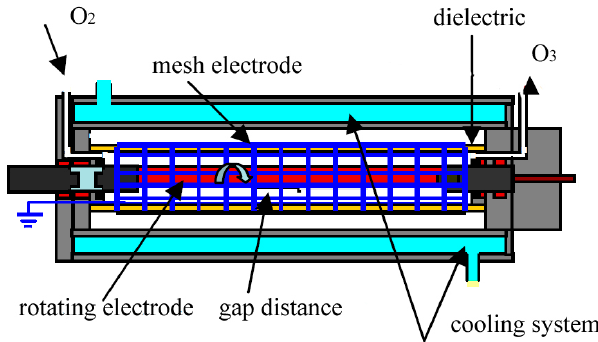
Figure 1. Schematic diagram of plasma reactor with rotating electrode.